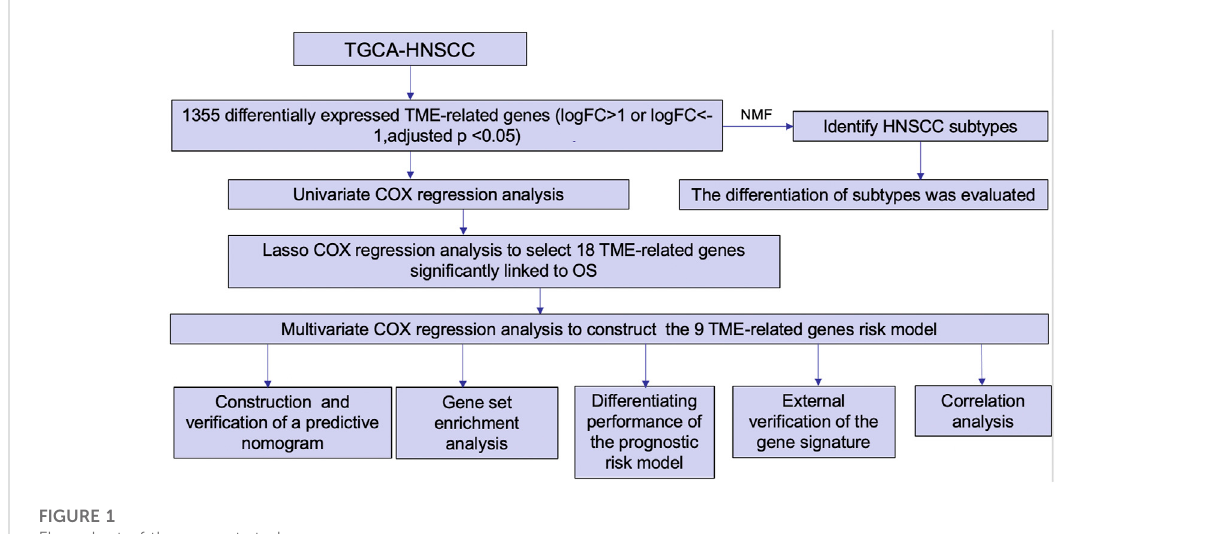
FIGURE 1 Flow chart of the present study.